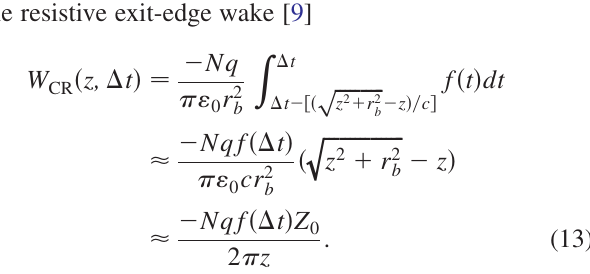
(cid:3) =(cid:1) 2 , integrating Eq. (13) d (cid:2) z